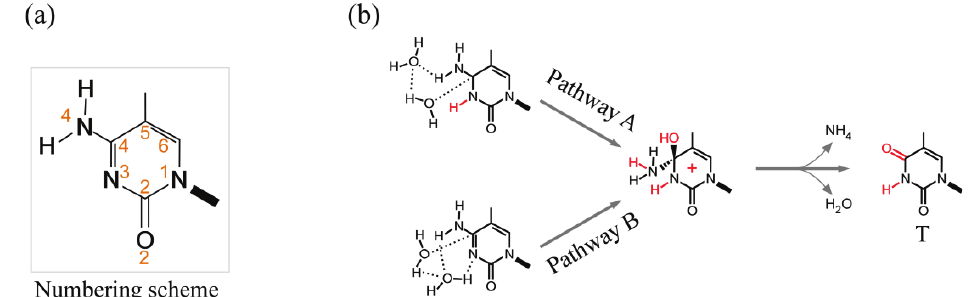
Figure 3. ( a ) Numbering scheme for cytosines; ( b ) Pathways for the spontaneous deamination of C and 5mC (only 5mC is